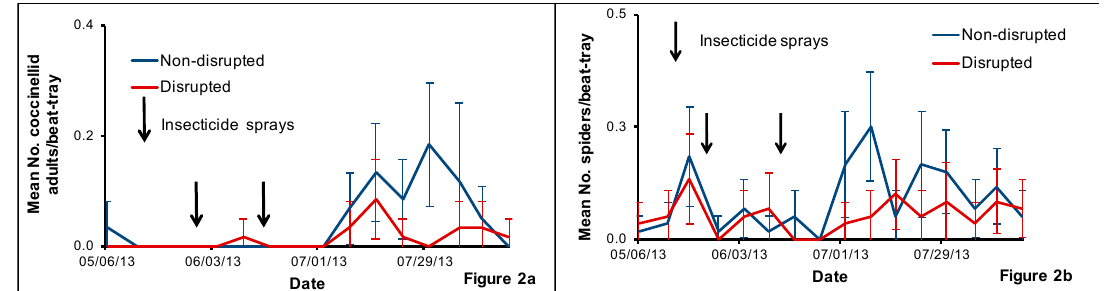
Figure 2. Mean number ( ± SE) of coccinellid adults ( a ) and spiders ( b ) per beat-tray collected in the natural enemy non-disrupted and disrupted plots in a pear orchard in White Salmon, Washington, USA, from May to August 2013. Significant differences between the treatments when present are noted on graphs using an asterisk (* = significance at p ≤ 0.05).